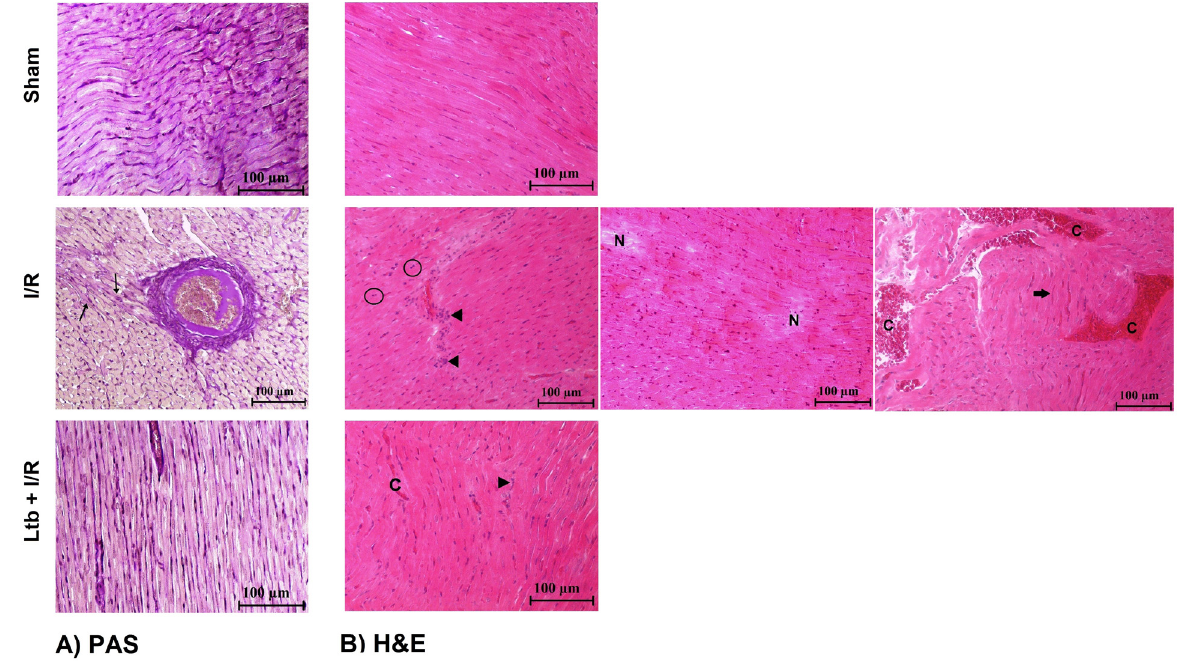
FIGURE 4 - A) PAS staining of rat heart. Sham ; Sham, normal structure of heart, I/R ; I/R group; Thin arrow: abnormal distribution of glycogen, Ltb + I/R ; glycogen content was similar with sham